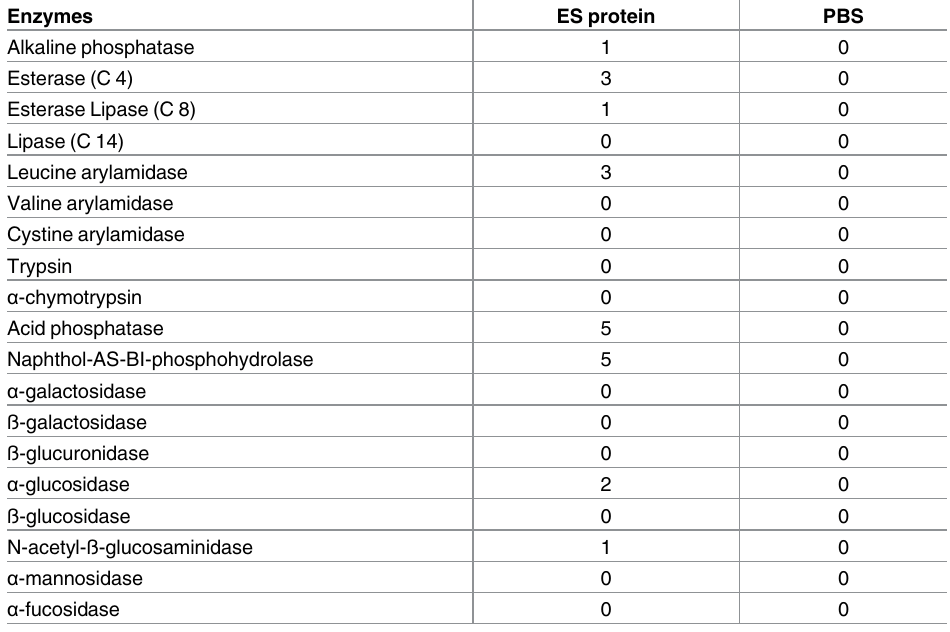
Phosphate buffer saline (PBS) was used as negative control. According to the colours developed, a value ranging between 0 and 5 is assigned; 0 corresponds to a negative reaction and 5 to a reaction with maximum